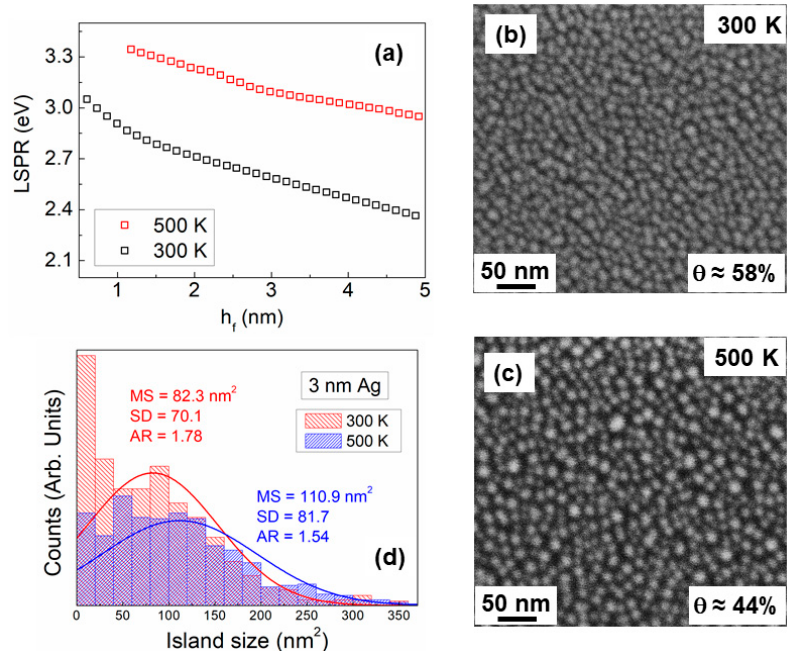
Figure 9. Morphological studies of discontinuous Ag layers deposited by magnetron sputtering on SiO 2 substrates (base pressure 10 − 8 Pa; working pressure 1.3 Pa; F = 0.1 nm / s) at two deposition temperatures of T = 300 and 500 K (unpublished data by Pliatsikas and Sarakinos). ( a ) Evolution of localized surface plasmon resonance (LSPR) vs. nominal film thickness, as determined from in situ and real-time SE. Plan-view SEM images of 3 nm thick films are shown in ( b ) for T = 300 K and ( c ) for T = 500 K. ( d ) Quantitative analysis of SEM images with regards to island size distribution, mean island size MS, size standard deviation SD, and in-plane aspect ratio AR.